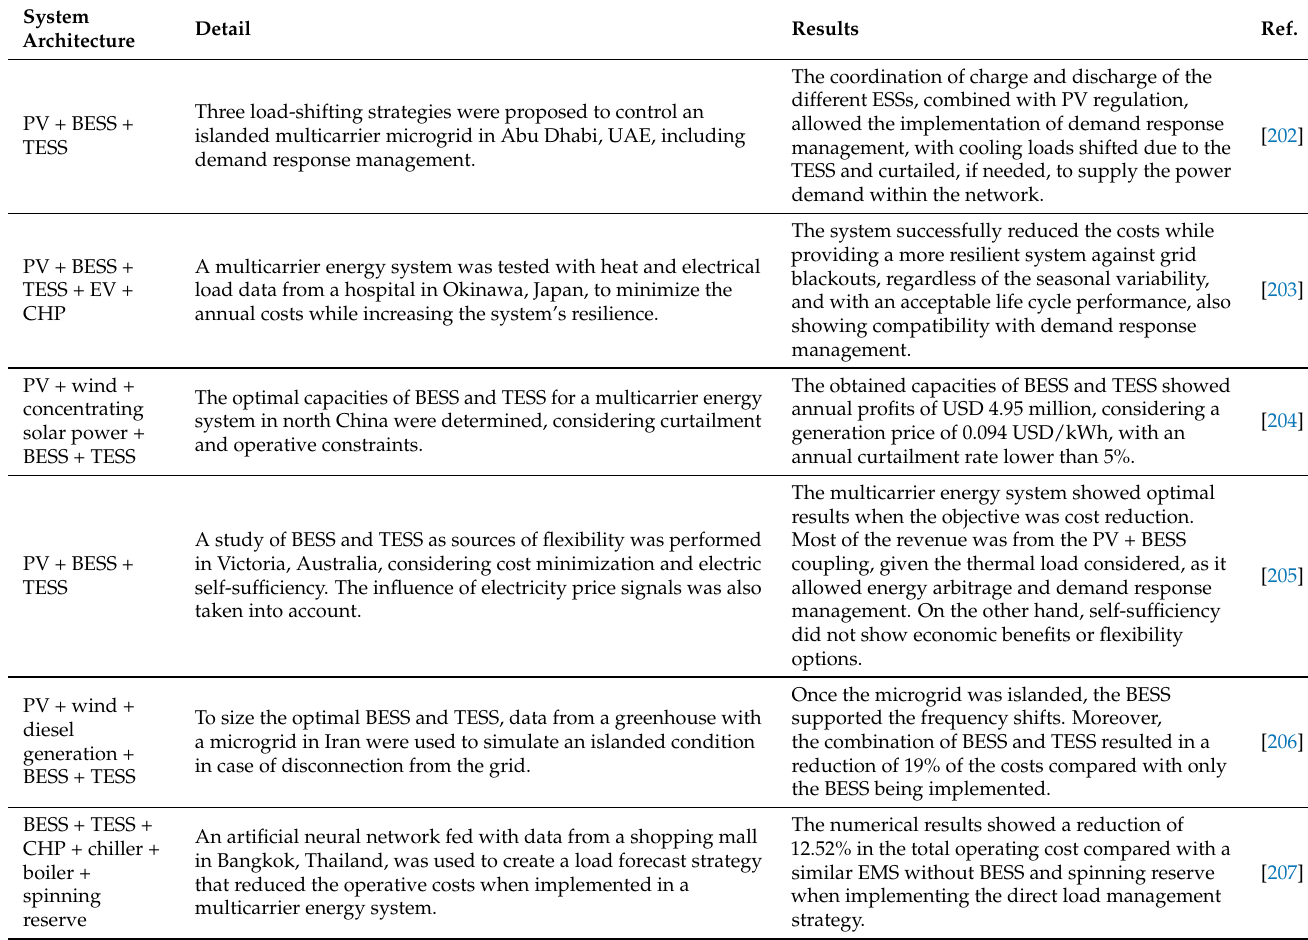
Table 5. Reported implementations of ancillary services through multicarrier energy storage systems. Results